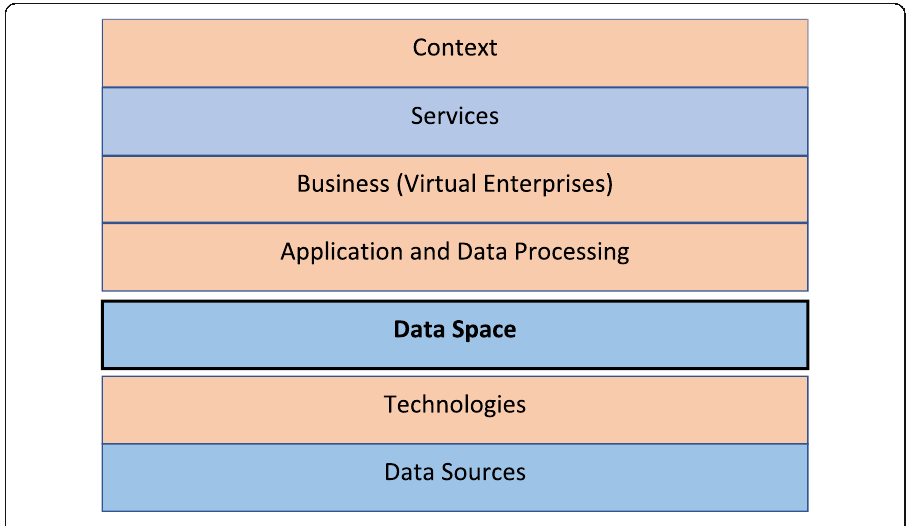
Fig. 4 Designed architecture adapted from (Petersen et al.